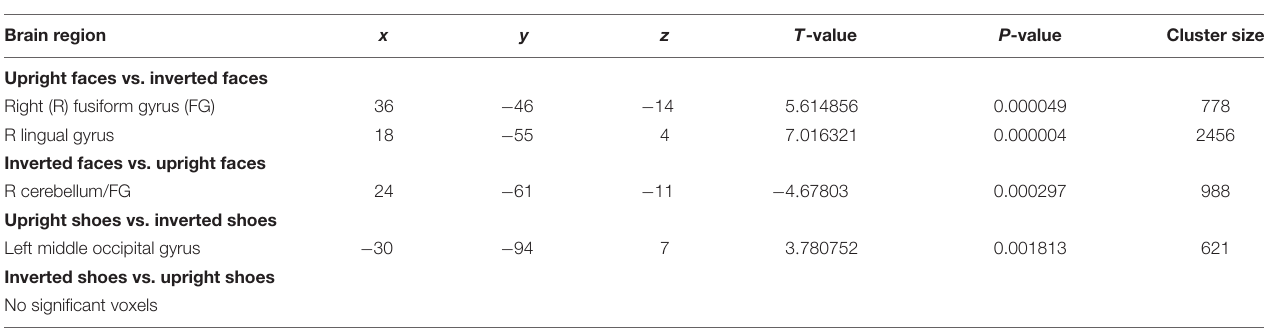
TABLE 3 | Orientation effects for each stimulus category. Brain region x y z T -value P -value Upright faces vs. inverted